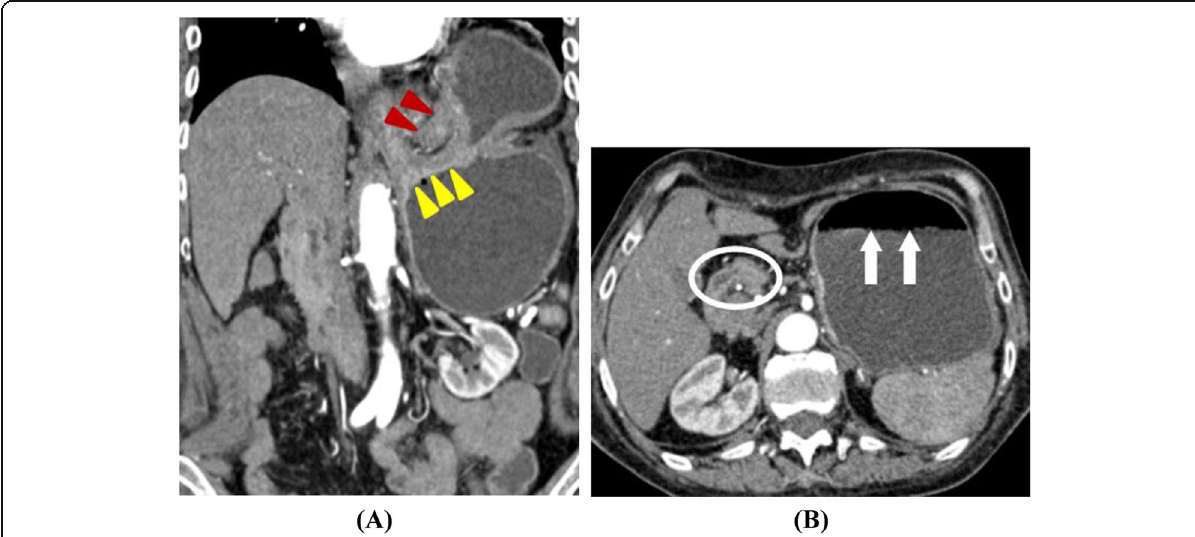
Fig. 1 Mesenteroaxial gastric volvulus in a 70-year-old female patient presented with sudden onset of vomiting and epigastric pain. a Coronal reformatted contrast-enhanced CT image shows gastric obstruction secondary to mesenteroaxial volvulus with the gastric antrum (red arrowheads) located superior to the gastroesophageal junction (yellow arrowheads). b Axial contrast-enhanced CT image shows gastric distention with air-fluid levels (arrows) with decompressed duodenum